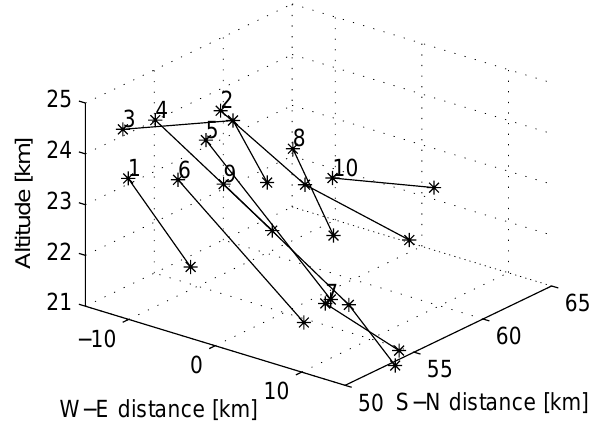
Fig. 12. Time development of a single visually identified feature in the PSC field observed on 9 January 1997. A minimum of two points in the contour have been identified in each image pair where possible. As above, distances are in km relative to the Kiruna sta- tion. The numbering refers to the same times of day as the abscissae of Fig. 13, in ascending order.